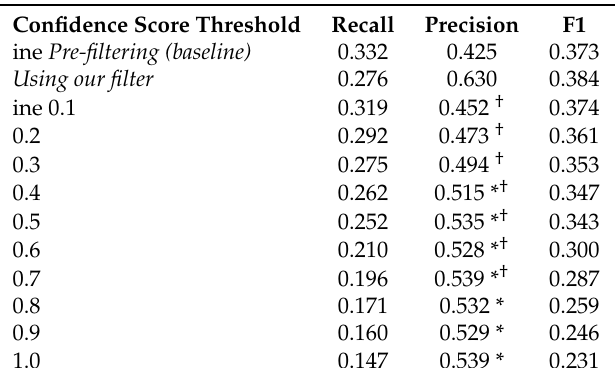
Table 11. Results obtained by Relation Factory using the TAC KBP 2013 Slot Filling scorer on the test dataset after filtering when using a confidence score threshold heuristic (Precision increase is significant for p -value < 0.1. Statistical significance is indicated with * when comparing our filter with the heuristic filter and with † when comparing the heuristic filter with the